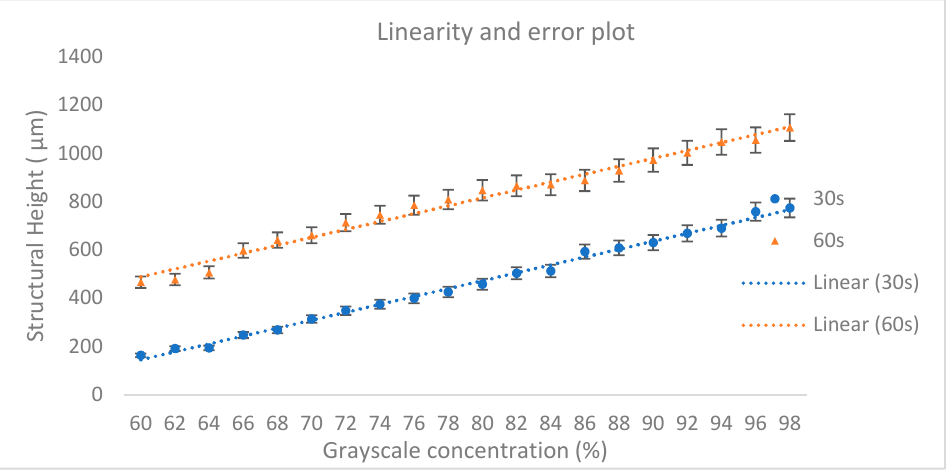
Figure 8. Linear plot at grayscale concentration between 60%–98% for 30 and 60 s UV exposure time.